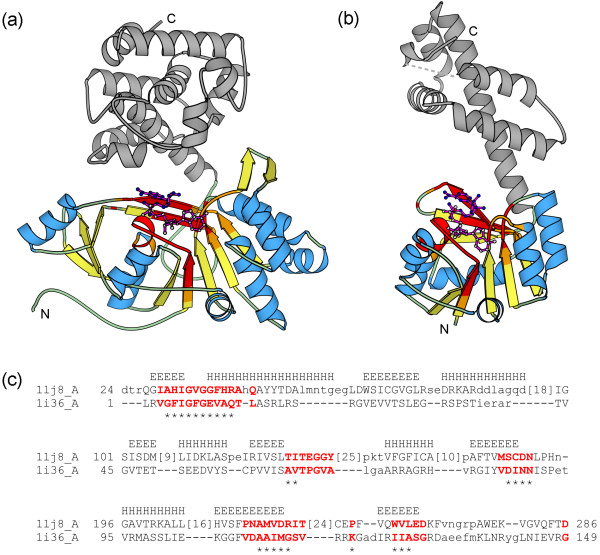
Correctly mapped remote homolog: N-terminal domain of mannitol 2-dehydrogenase. a) Ribbon diagram of mannitol 2-dehydrogenase from Pseudomonas fluorescens (PDB: 1lj8 [19]). The N-terminal domain is shown in color. Regions in red are positions among the top 25% of most conserved positions in both the query (1lj8_A, N-terminal domain) and library representative (1i36_A, N-terminal domain). Regions in orange are positions among the top 25% of most conserved positions in either the query or the library representative domain, but not both. Positions in this domain that are not among the most highly conserved are blue (α-helices), yellow (β-strands), and green (coils). The C-terminal domain is shown in grey, and the bound nucleotide in shown in ball-and-stick format and is colored magenta. This and all other structure figures were prepared using MOLSCRIPT[48]. b) Ribbon diagram of conserved hypothetical protein MTH1747 from Methanobacterium thermoautotrophicum (PDB: 1i36). The N-terminal domain, shown in color, is a representative of the NAD(P)-binding Rossmann-fold superfamily. The colors have equivalent meaning to those in figure 3a. The C-terminal domain is shown in grey, and nucleotide in shown in ball-and-stick format and is colored magenta. Dashed lines indicate breaks in the chain. c) Pairwise alignment of the query (1lj8_A) and library representative (1i36_A) from DaliLite results. Residues in red bold text are among the top 25% of most conserved positions in at least one of the domains. Residues indicated with an asterisk are among the top 25% of most conserved positions in both the query and library domains. Secondary structure is indicated above the alignment, with E signifying β-strand residues and H signifying α-helix residues. In this and other alignments, the numbers flanking the alignment indicate the residue number in the sequence of the first (or last) aligned residue on that line. Numbers in brackets specify the number of residues in an insert that are not shown. In all alignments produced based on DaliLite results, capital letters are aligned residues and lower-case letters are unaligned residues.